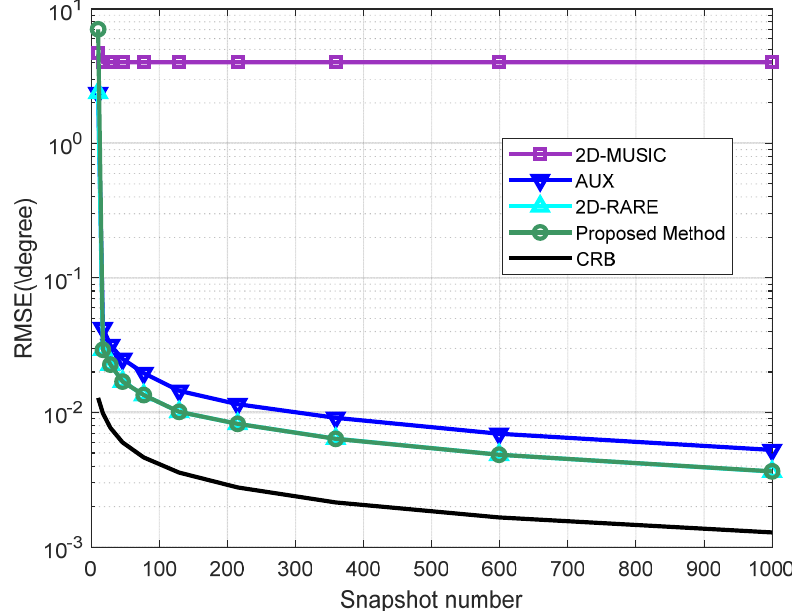
Figure 4. RMSEs of DOA estimates versus the number of snapshots. The SNR is 10 dB.